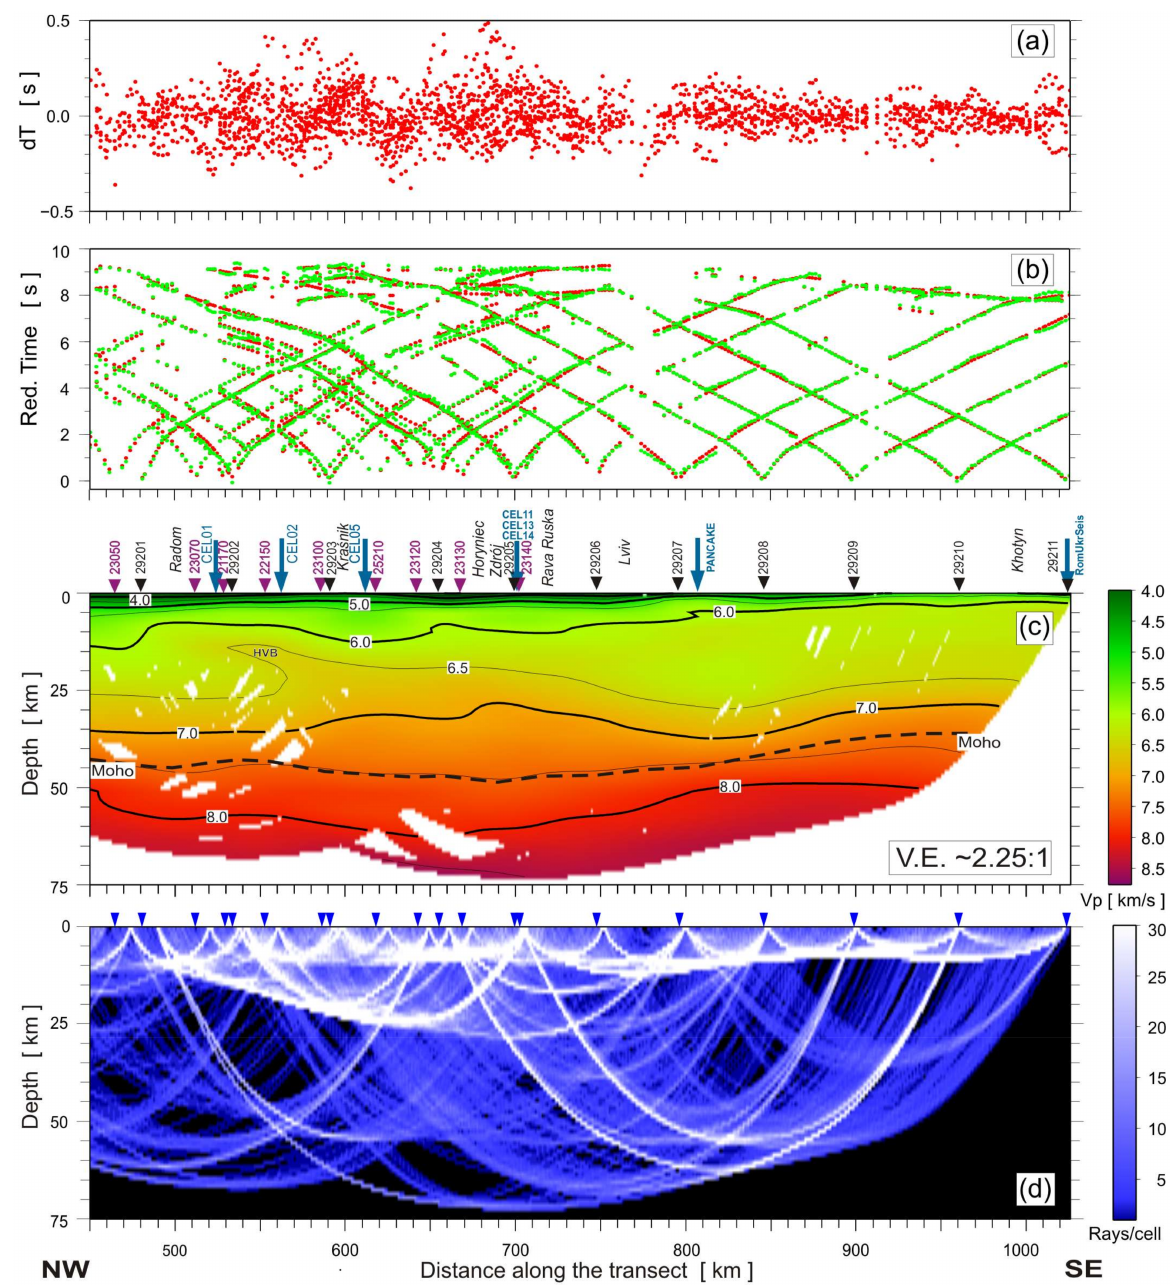
Figure 6. Results of two-dimensional tomographic inversion of P-wave first arrival travel times obtained using the program package by Hole [105]. Diagrams show ( a ) Travel time residuals; ( b ) Theoretical and observed travel times; green points—observed P-wave arrivals, red points— theoretical travel times, reduction velocity is 8 km/s; ( c ) Two-dimensional tomographic P-wave velocity model, where numbers are velocities in km/s, black dashed line marks Moho interface, and HVB is the h igh- v elocity b ody; ( d ) Ray coverage from tomographic modelling along the